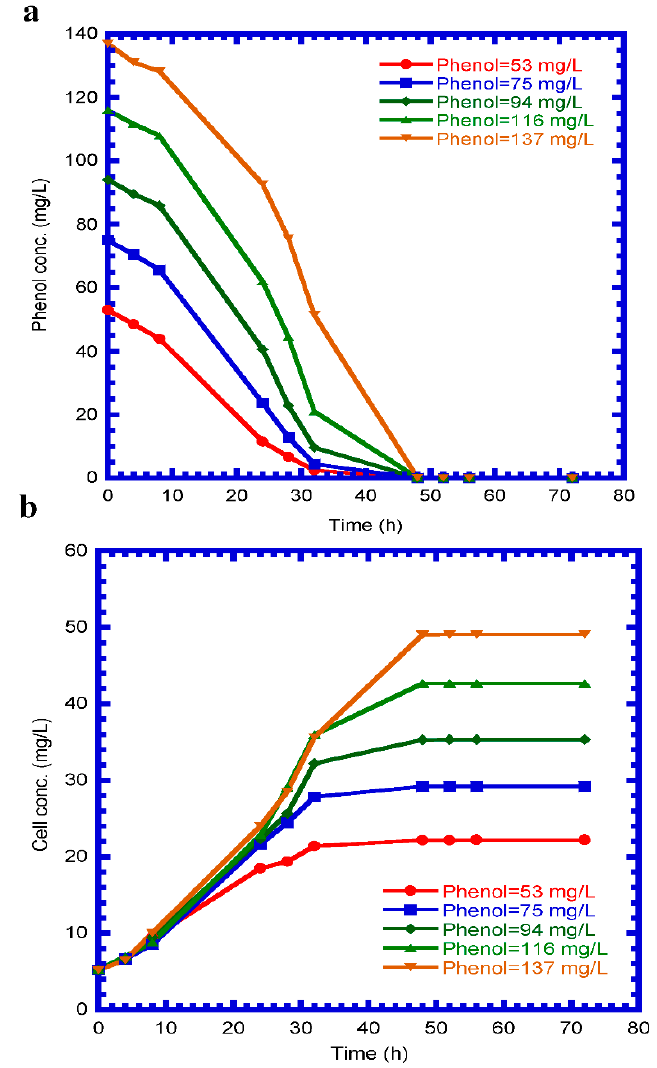
Figure 2. Time profile of different parameters: ( a ) phenol degradation, ( b ) cell growth.